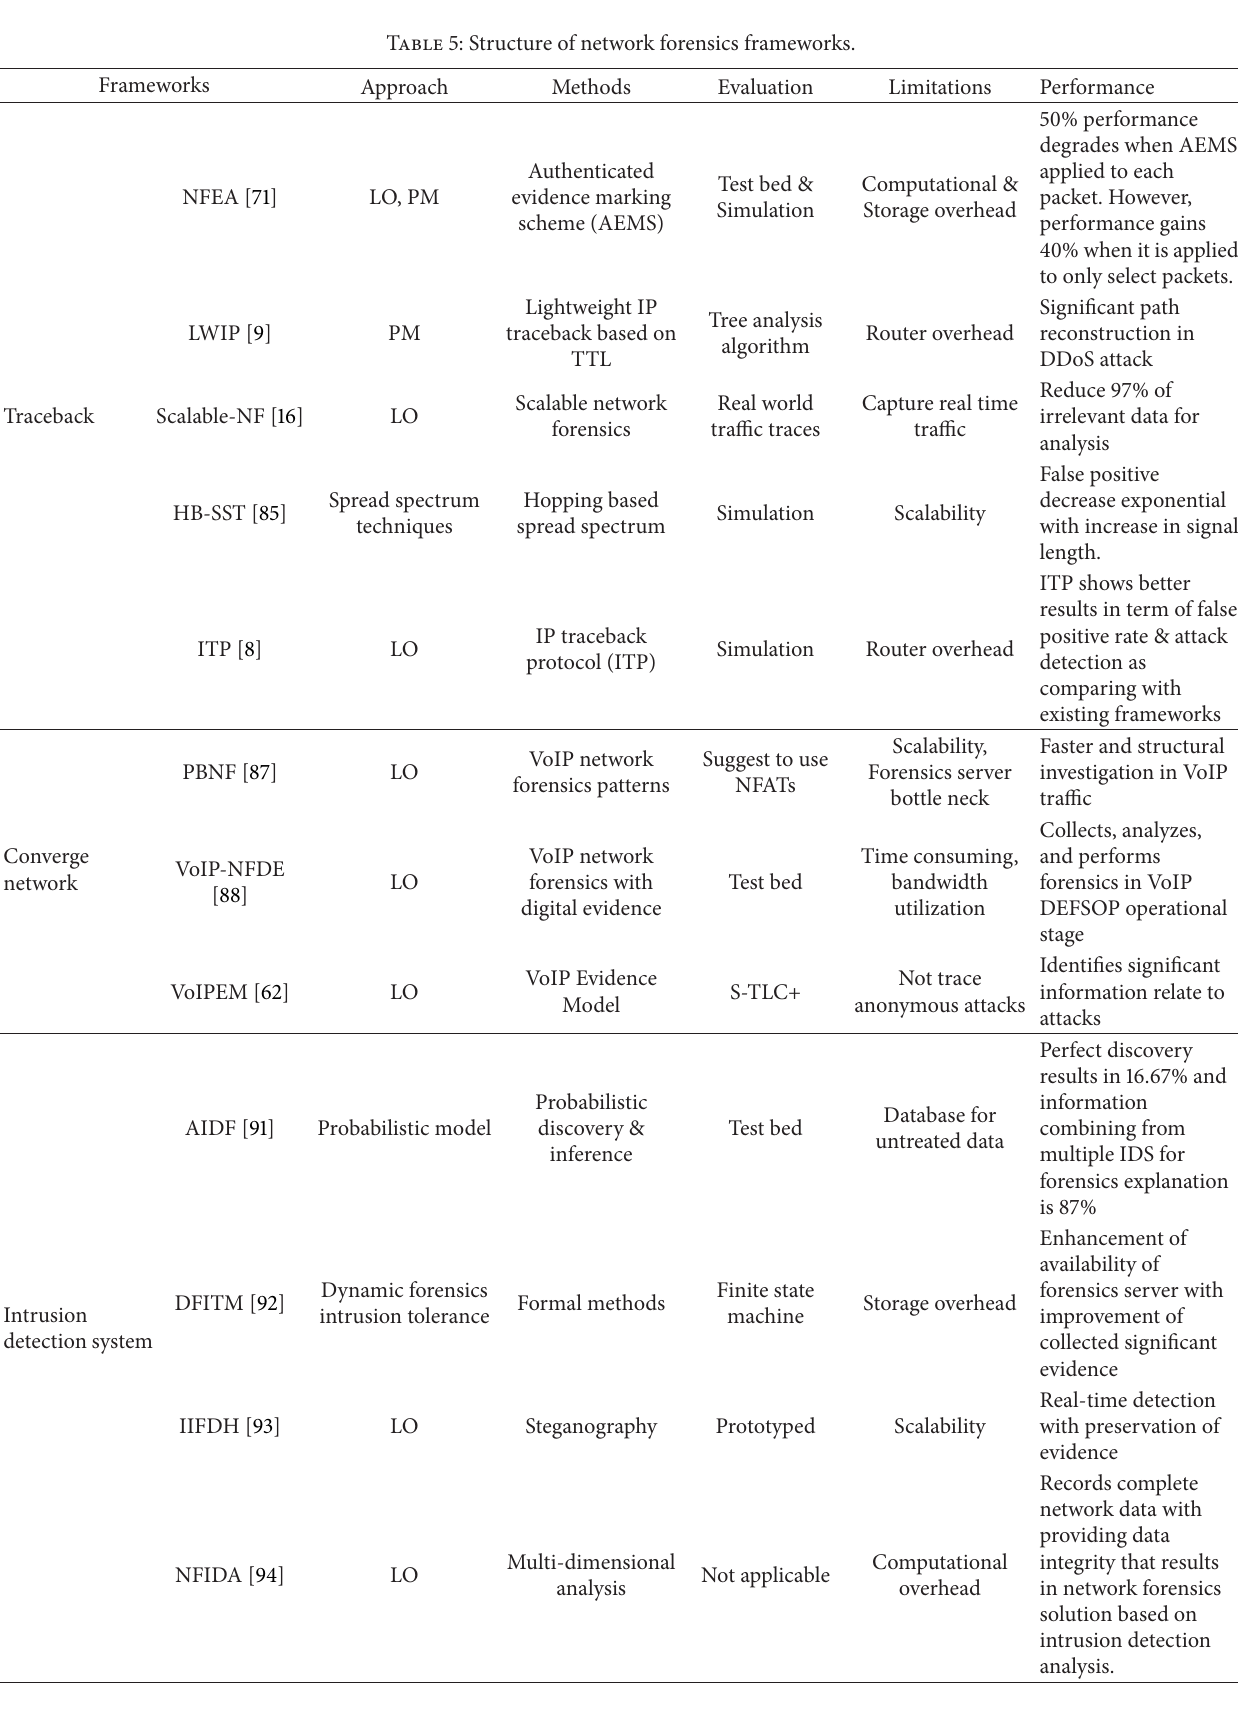
Table 5: Structure of network forensics